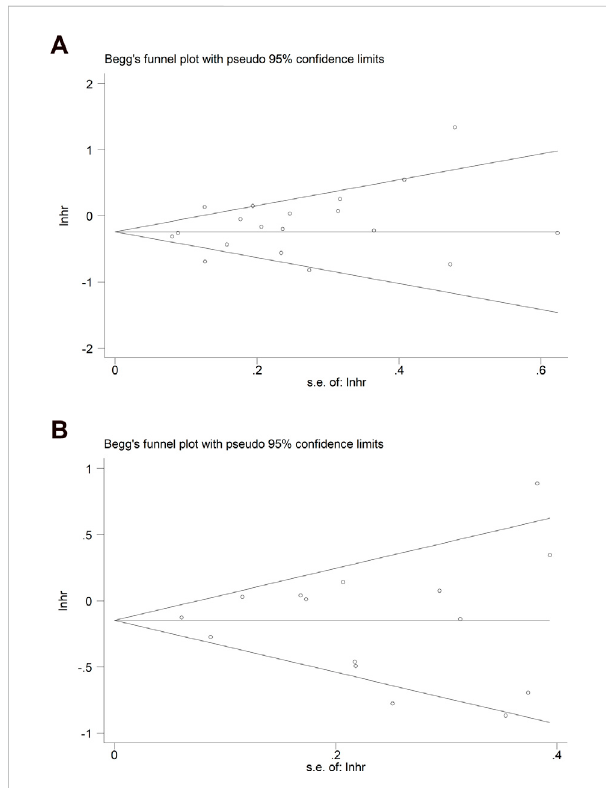
FIGURE 6 Begg ’ s funnel plots for (A) overall survival and (B) progression- free